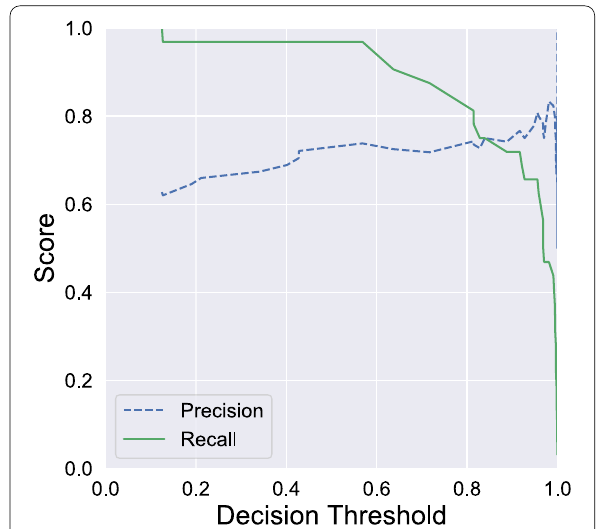
Fig. 2 Precision and sensitivity score of gradient boosting models on validation data with different decision